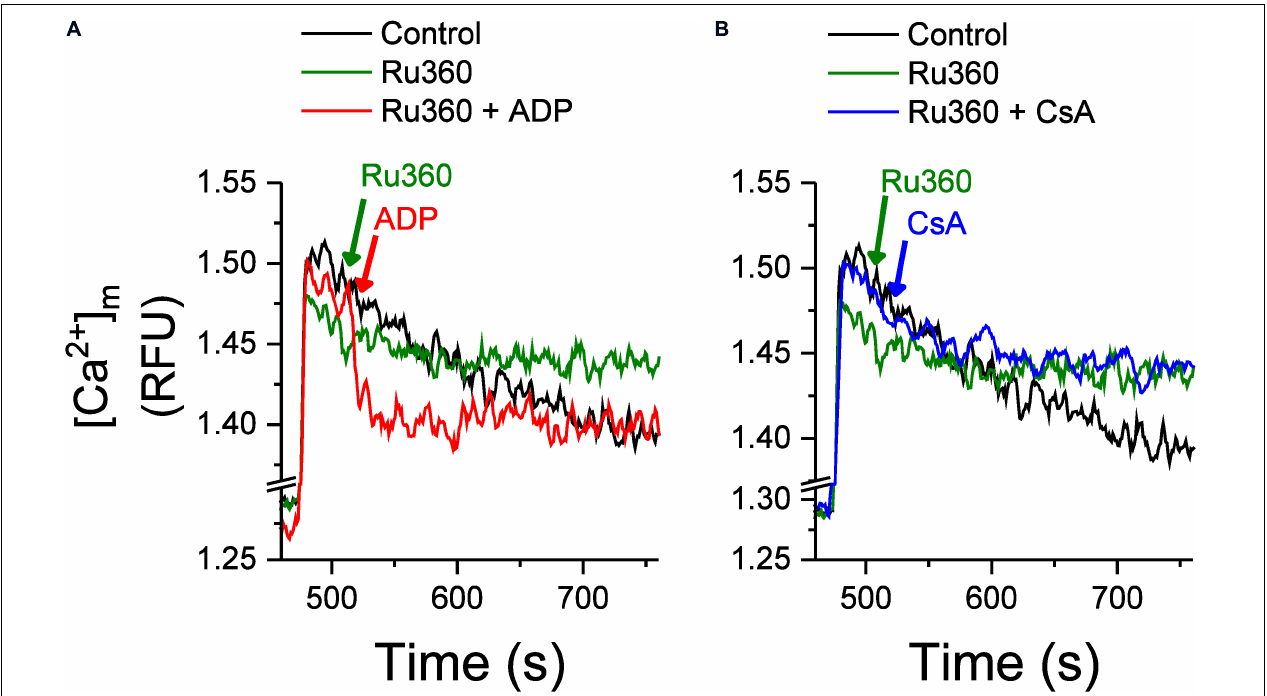
FIGURE 4 | Effect of ADP and CsA on Ca 2 + buffering and intra-matrix Ca 2 + . Changes in intra-matrix Ca 2 + in mitochondria isolated from rat hearts in response to 20 µ M CaCl 2 bolus in the absence (control, black) or presence of 1 µ M Ru360 applied at 500 s (green) followed by either (A) ADP (red) or (B) CsA (blue) at 520